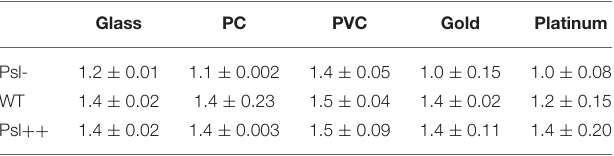
on the five chosen surfaces. ++